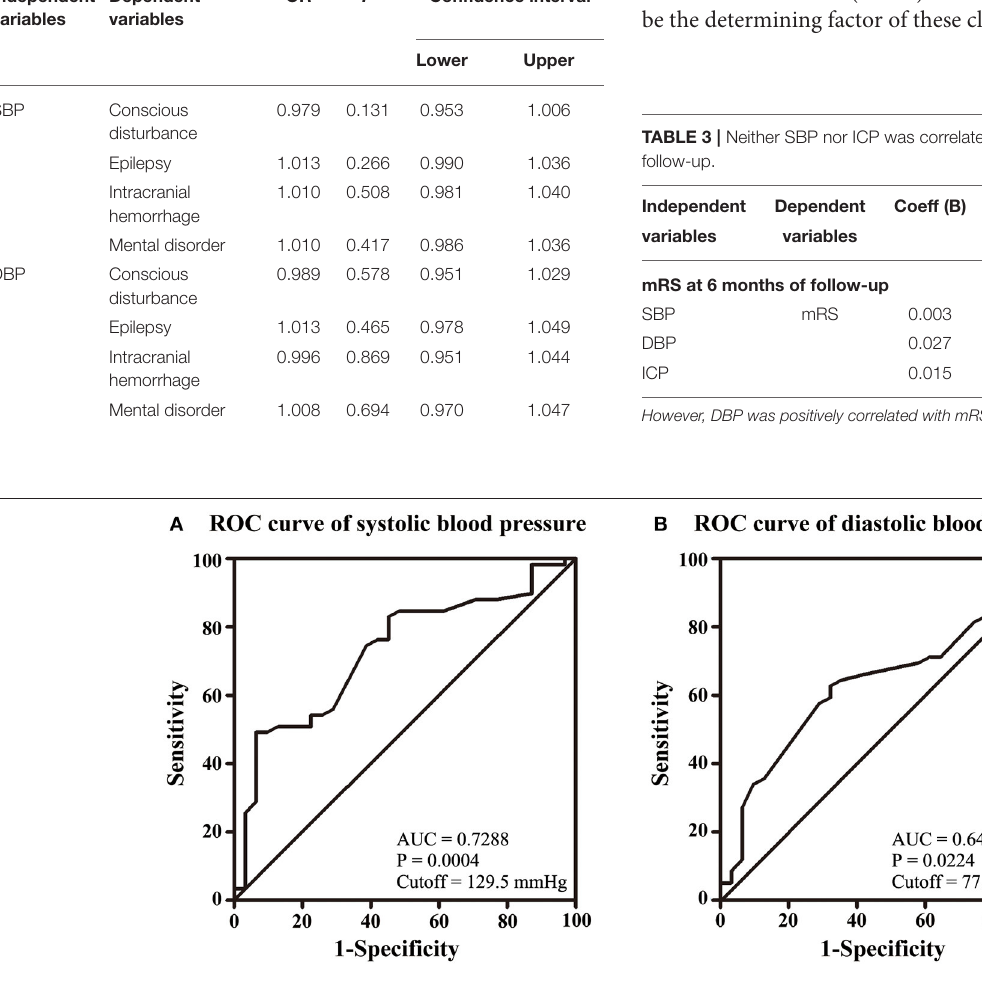
Frontiers in Neurology |